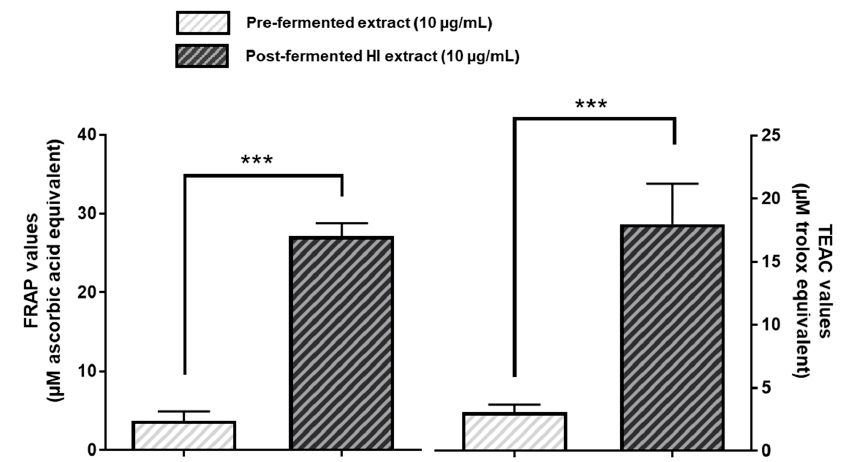
Figure 6. Post-fermented HI-rich soy extract exhibited higher antioxidative capacity than pre-